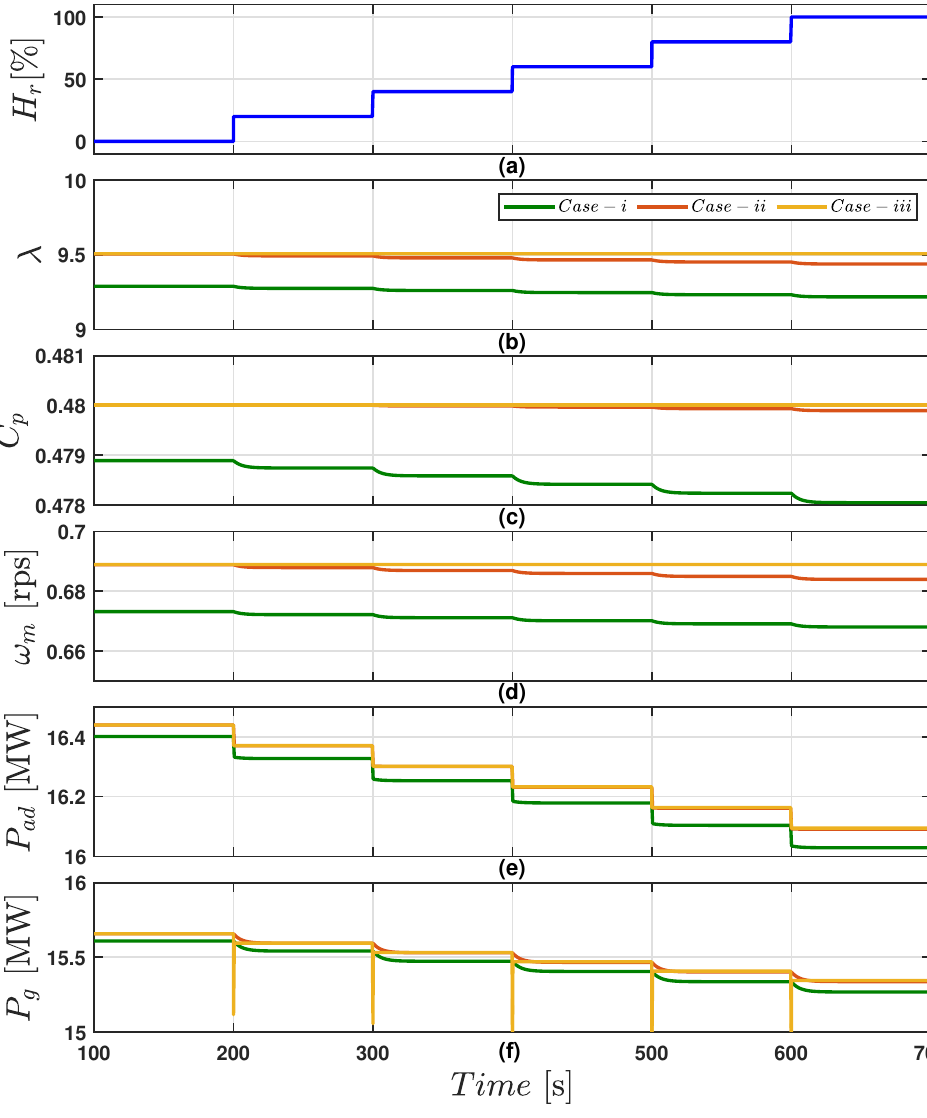
Figure 7. Simulation results of 20 MW WTS under varying humidity. ( a ) Relative humidity. ( b ) Tip-speed ratio. ( c ) Power coefficient. ( d ) Rotor speed. ( e ) Aerodynamic power. ( f ) Power delivered to the